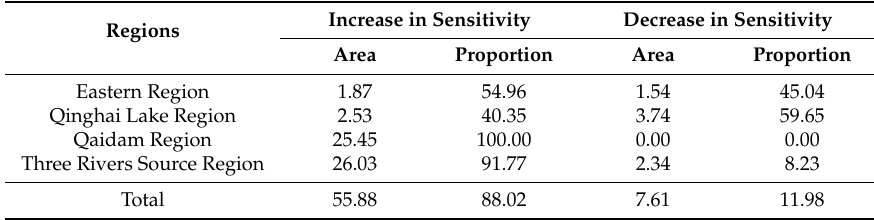
Table 6. Change of sensitivity in different regions from 1988 to 2008 (unit: 10 4 km 2 ; %). The division of the four regions in Qinghai Province is sourced from